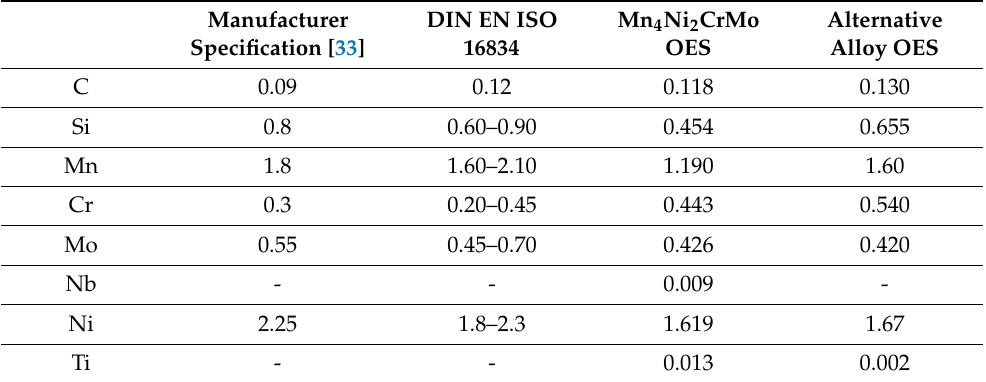
Table 3. Chemical Table 3. Chemical composition.